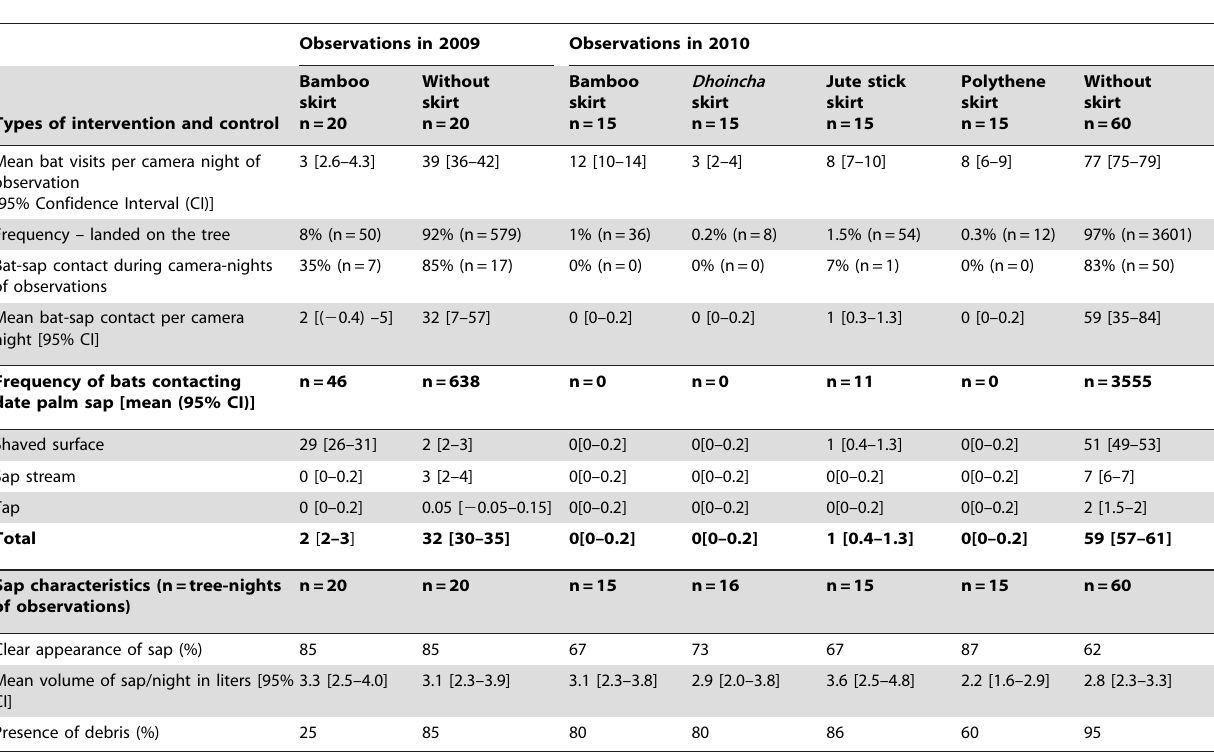
Table 1. Frequencies of bat visits to different parts of date palm sap tree with and without interventions and comparison of sap in terms of appearance, volume and presence or absence of